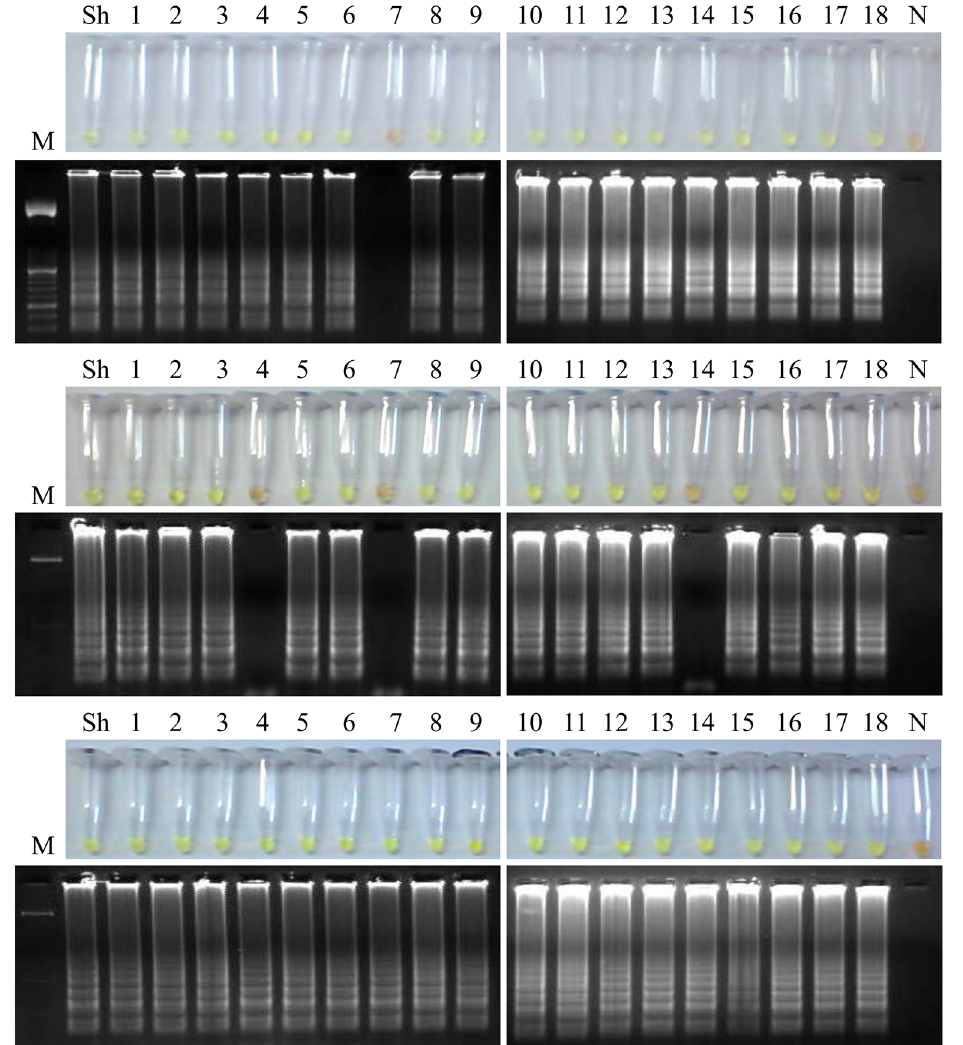
Fig 7. Examination of aliquots of urinary sediment (pellets) from S . haematobium -positive patients´ urine samples by LAMP. Figure shows the LAMP results (up, by color change; down, by agarose electrophoresis) when using aliquots of 100 μ L of pellets to obtain DNA as template by using (A) the i- genomic Urine DNA Extraction Mini Kit (Intron Biotechnology, UK); (B) the heating NaOH-SDS method and (C) the rapid heating method-the rapid-heat LAMPellet method-. Lanes M: 50 bp DNA ladder (Molecular weight marker XIII, Roche); lanes Sh: genomic DNA from S . haematobium (1 ng); lanes 1 – 18: S . haematobium -positive samples; lanes N: negative controls (no DNA template).